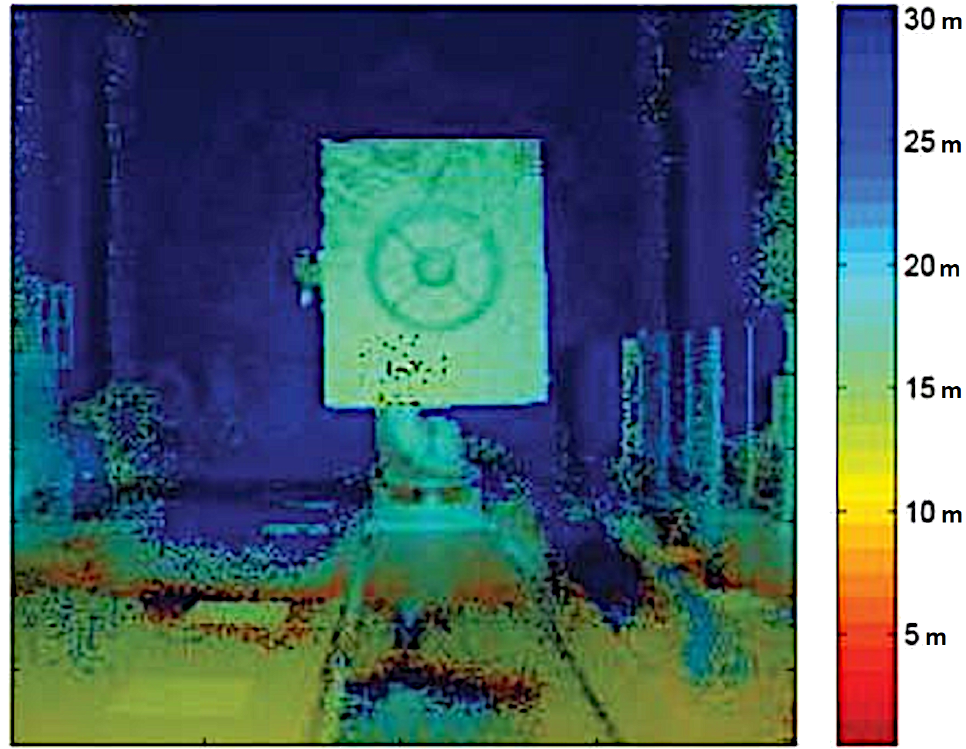
Figure 7. Range image captured with CamCube PMD